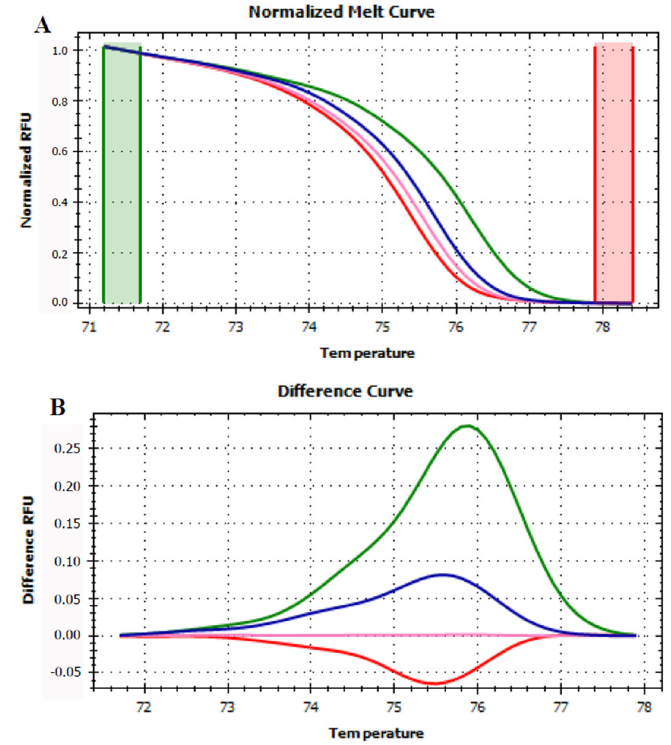
Figure 3. Normalized melt curve ( A ) and difference curve ( B ) of HRMA of P6 loop of trnL (UAA) intron on fresh fruits. Apple: red, pear: pink, peach: blue and kiwi: green. Reference cluster is pear fruit. The HRMA has been carried out on three independent replicates of each sample and the most representative curve of each sample is reported in the graph.